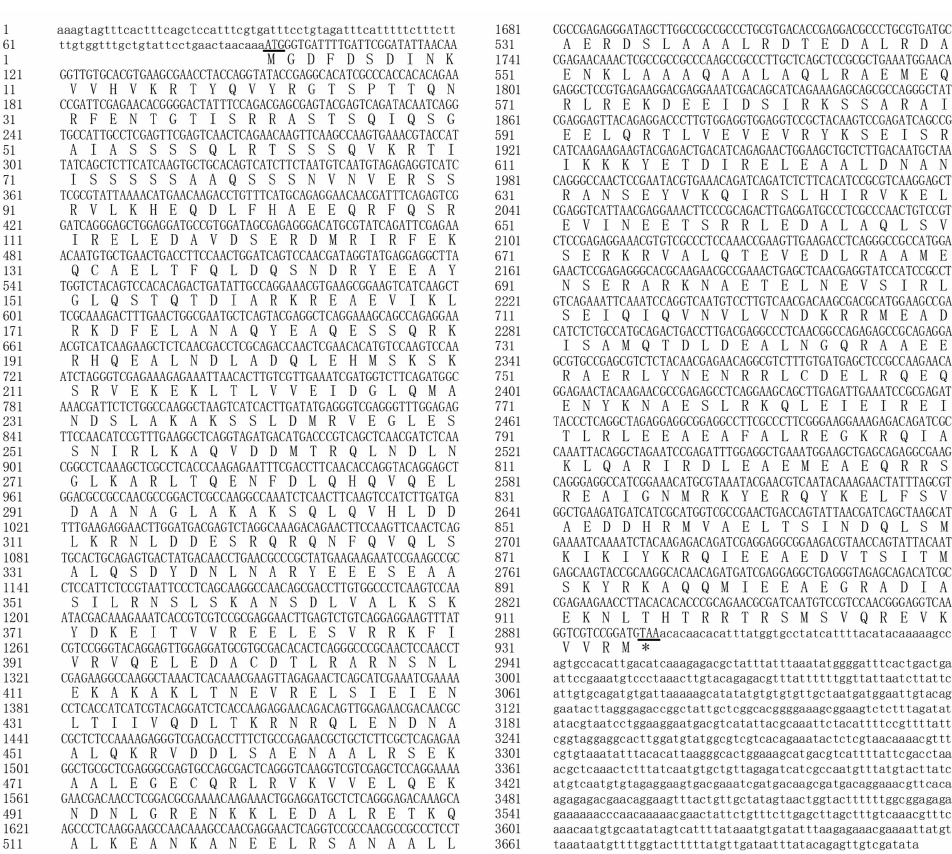
Figure 1. The complete cDNA sequences encoding paramyosin of Patinopecten yessoensis and its deduced amino acid sequences. The canonical start (ATG) and stop (TAA) codons are shown in